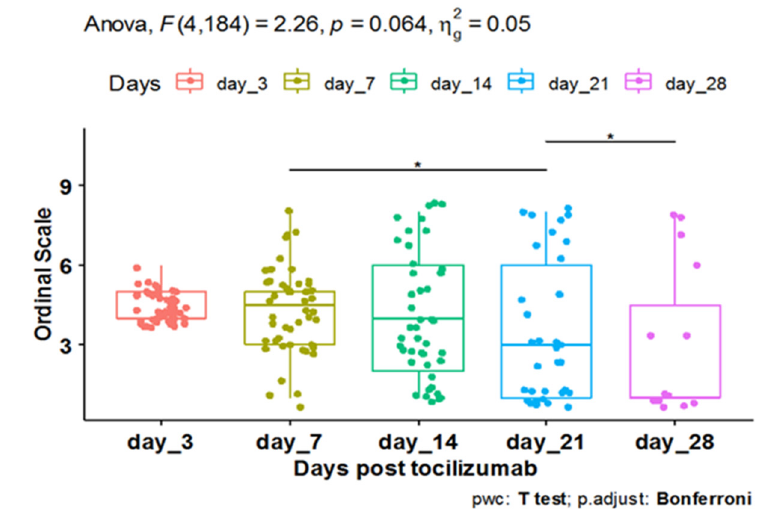
Figure 1. One-way Repetitive ANOVA for the comparison of the continuous WHO 8 ordinal scale at fixed time points (Days 3, 7, 14, 21, and 28) post-tocilizumab. (*: Significant Difference in the Pairwise Comparison).